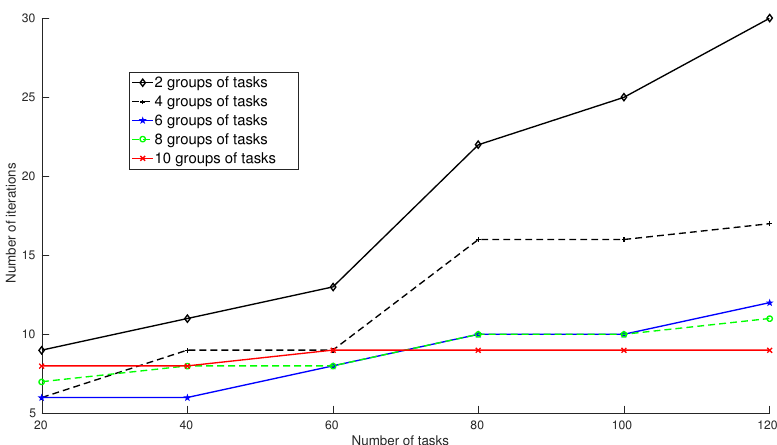
Figure 4. Number of iteration required to converge with fuzzy Markov chains for environments with two, four, six, eight and 10 cluster (groups) of